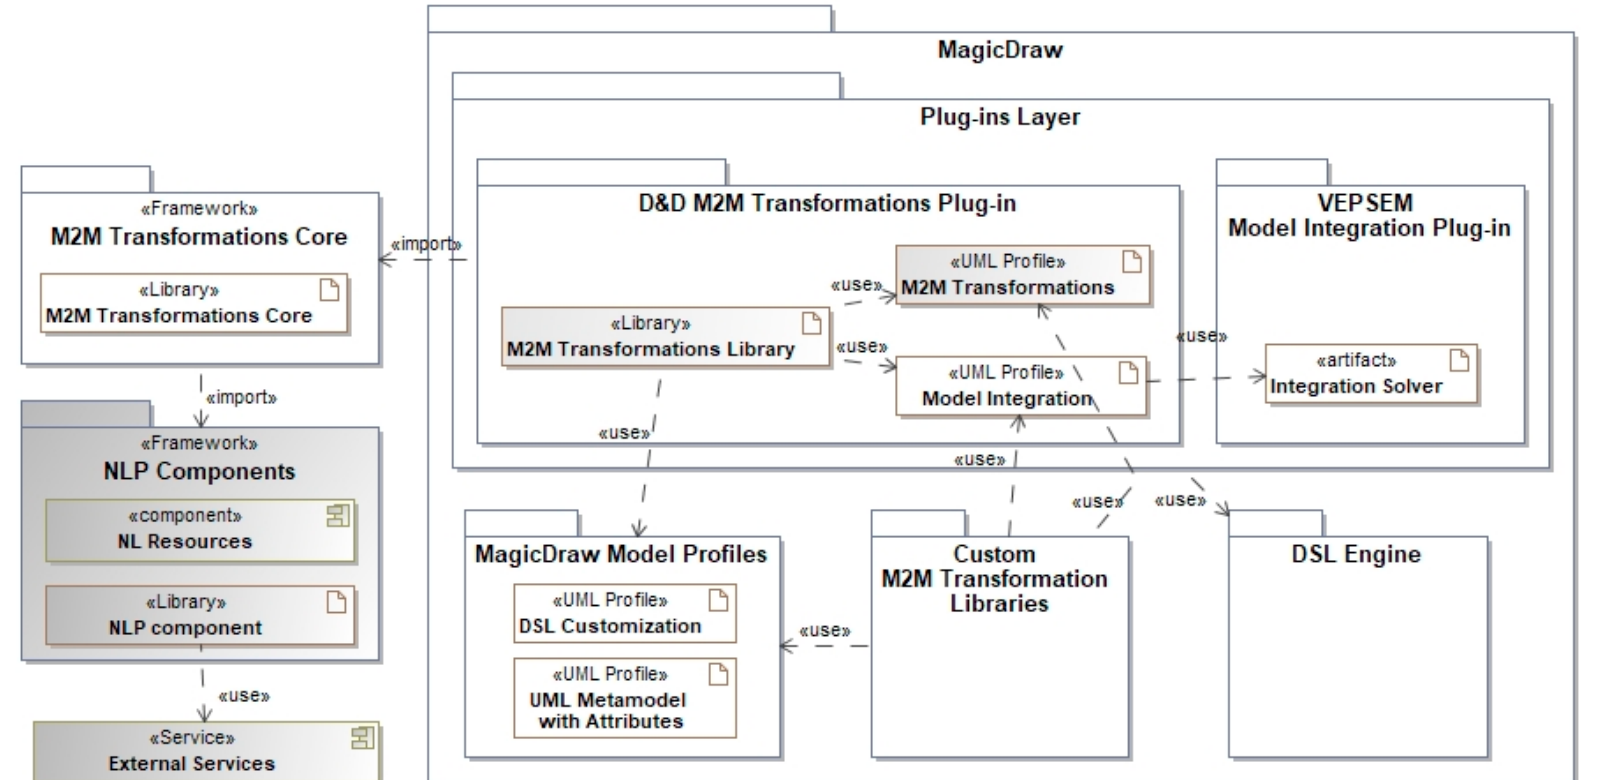
Figure 4. Implementation architecture of extended solution.